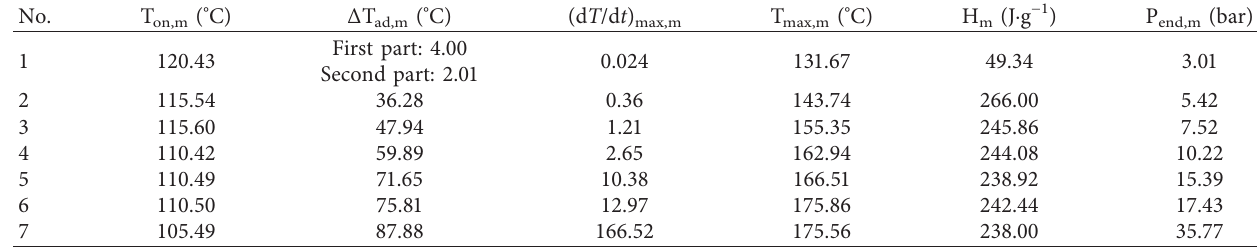
Table 6: Measured adiabatic test results of sample #2 with different Φ values.